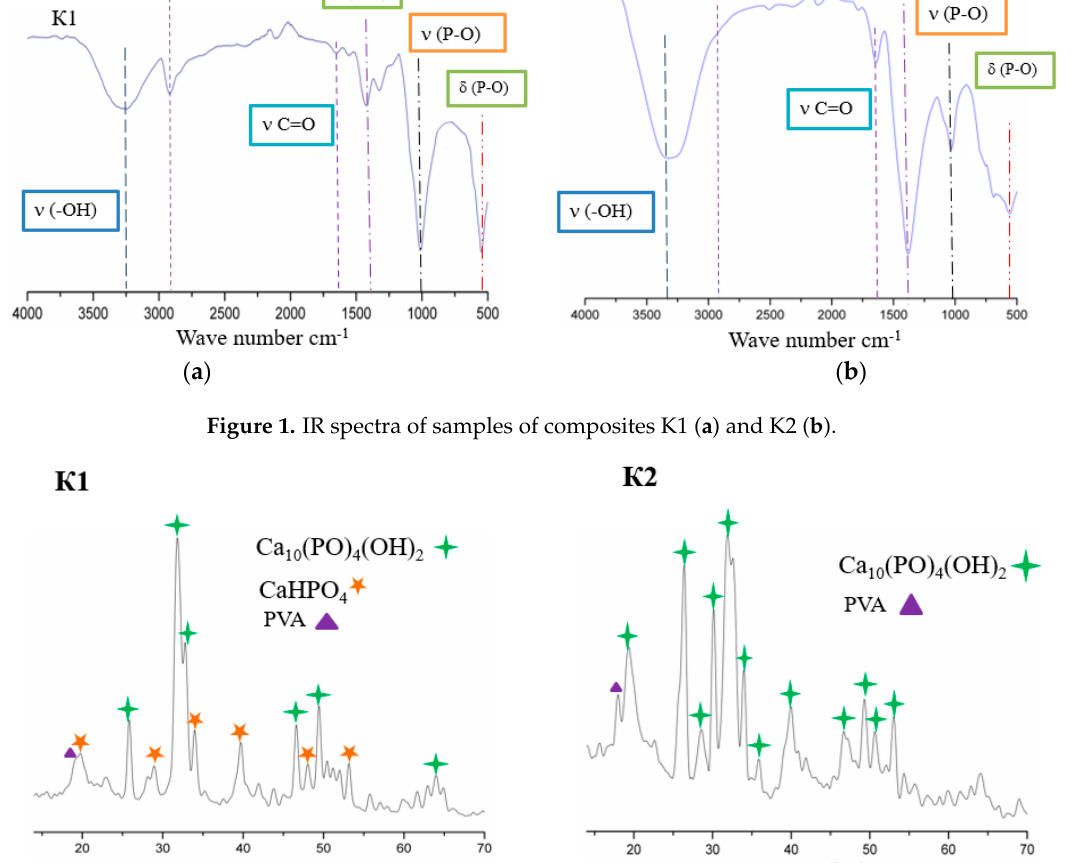
Figure 1. IR spectra of samples of composites K1 ( a ) and K2 ( b ).